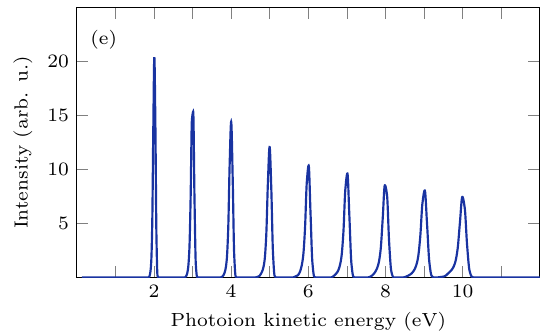
Figure 4. Simulation results for ion detection when the electron side is optimized for electron VMI (Operation Modes 2(a) and 2(b)). ( a ) shows the resulting mass resolution as a function of extractor voltage, V i , for ions with an initial velocity of v 0 = 1000 m/s in the direction of the molecular beam; E ( b ) shows the resulting VMI energy resolution for three different extractor voltages using the 27-particle model (blue, green and orange lines) and the Monte Carlo model for the optimum setting (solid black line). The dashed black line shows the resolution in Operation Mode 1(b) obtained by the Monte Carlo method, reproduced from Figure 2; ( c , d ) show the simulated detector image and the 3D momentum distribution after inversion, for the optimum voltages; ( e ) shows the kinetic energy spectrum calculated from the 3D momentum distribution.